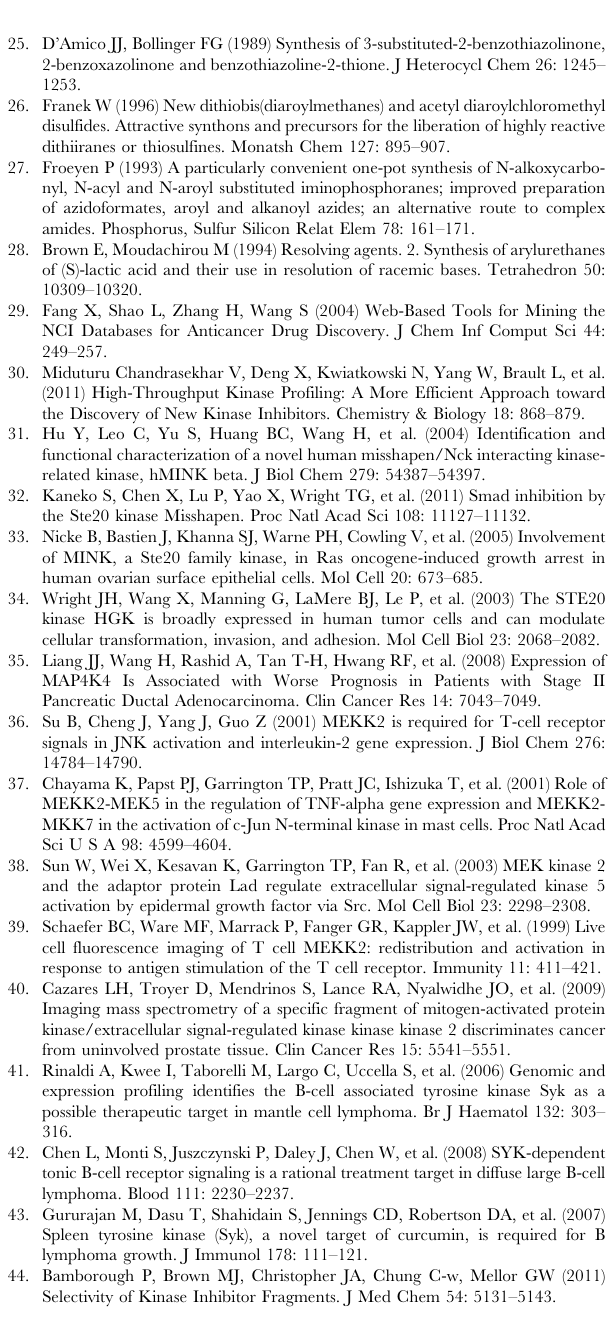
Figure S2 Schematic depiction of Protein Kinase Micro- array-based small molecule inhibitor profiling plat-